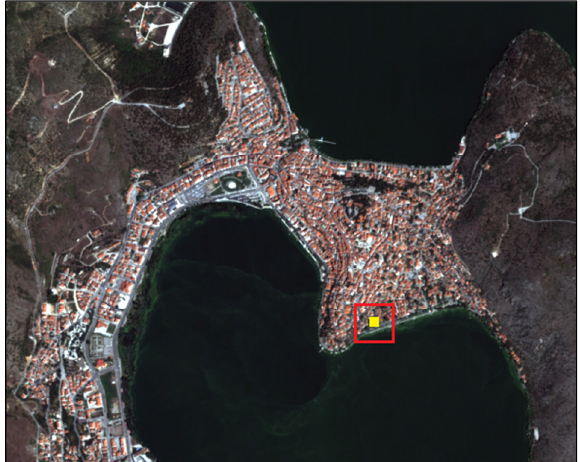
Figure 3. Position of Skoutaris Mansion (yellow dot) in the subset of QuickBird image covering the main part of the city of Kastoria.